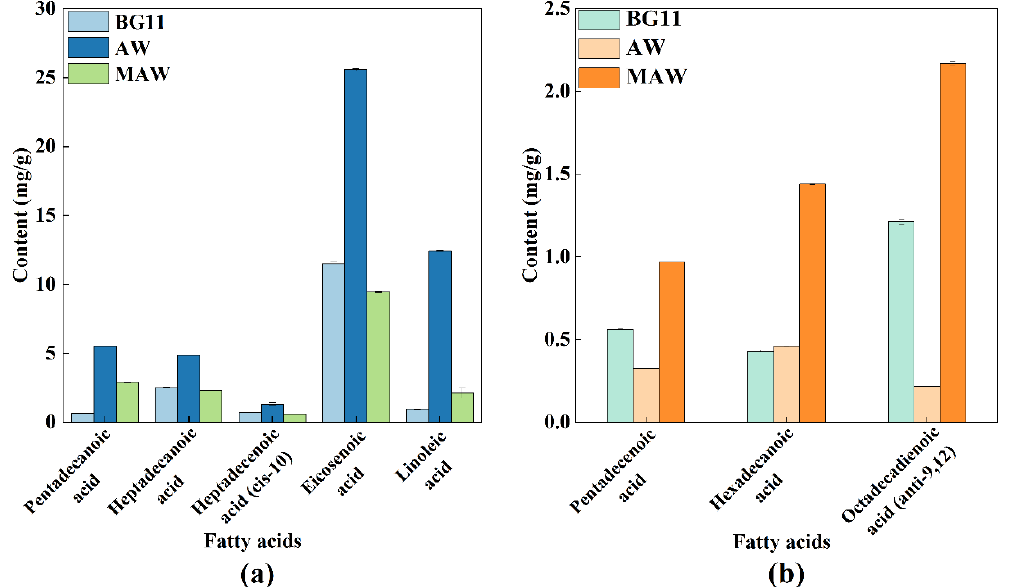
Figure 3. Contents of fatty acids in microalgae harvested by the three culture methods; ( a ) Pentadecanoic acid, Heptadecanoic acid, Heptadecenoic acid (cis-10), Eicosenoic acid and Linoleic acid, and ( b ) Pentadecenoic acid, Hexadecanoic acid and Octadecadienoic acid (anti-9,12).